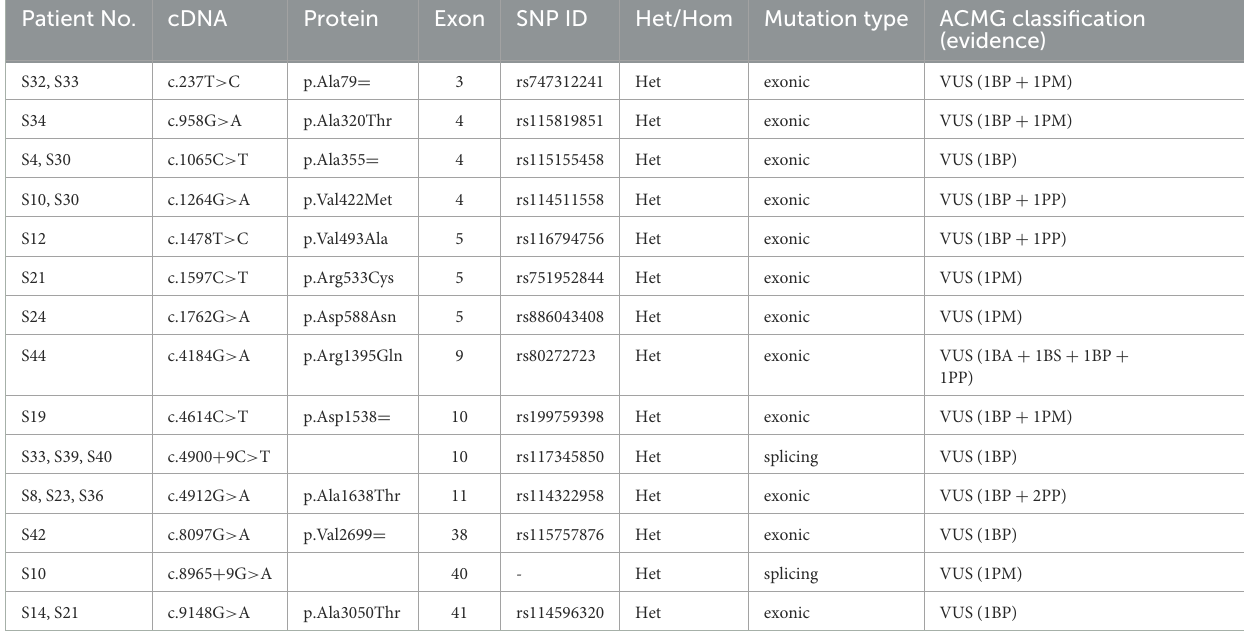
TABLE 2 Information of COL6A3 variants after ACMG classification. Patient